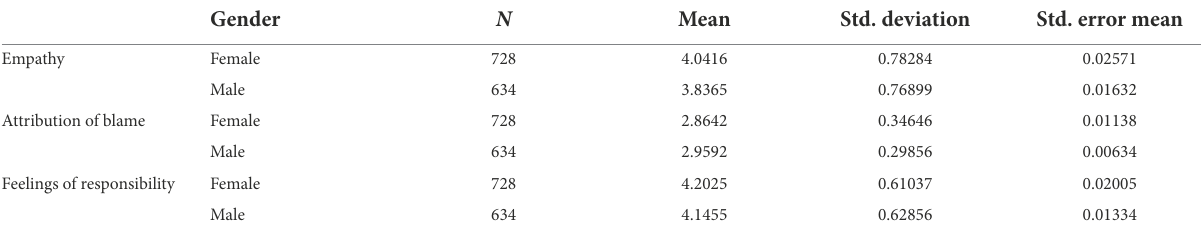
TABLE 7 Group Statistics on empathy, attribution of blame, and feelings of